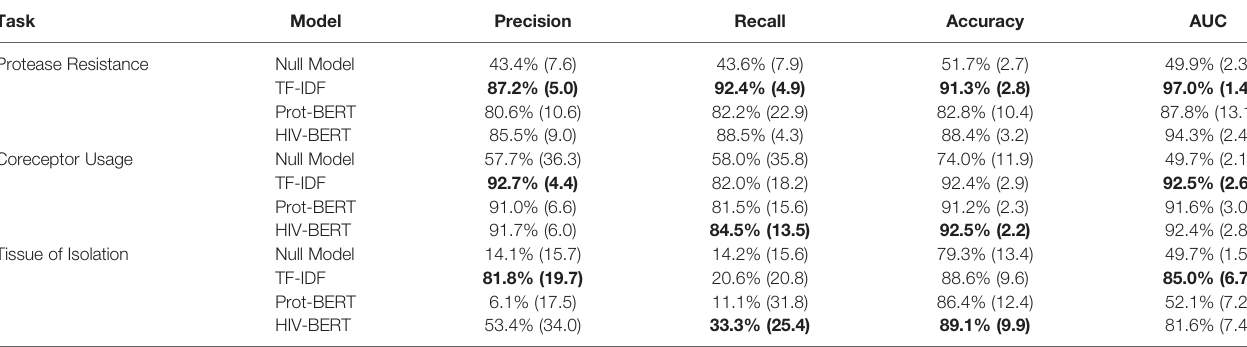
TABLE 1 | Average model performance metrics across 5-fold cross-validation.